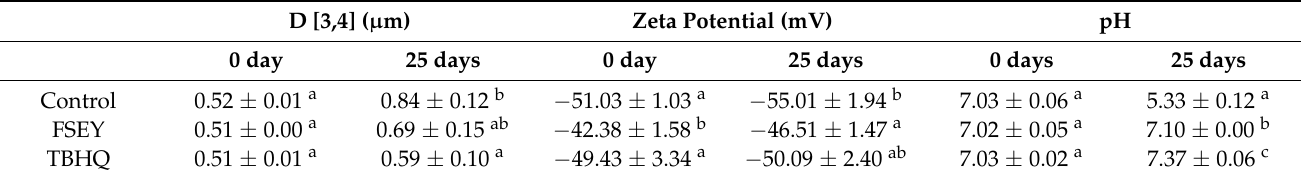
Table 1. ζ -potential values (mV) and volume mean